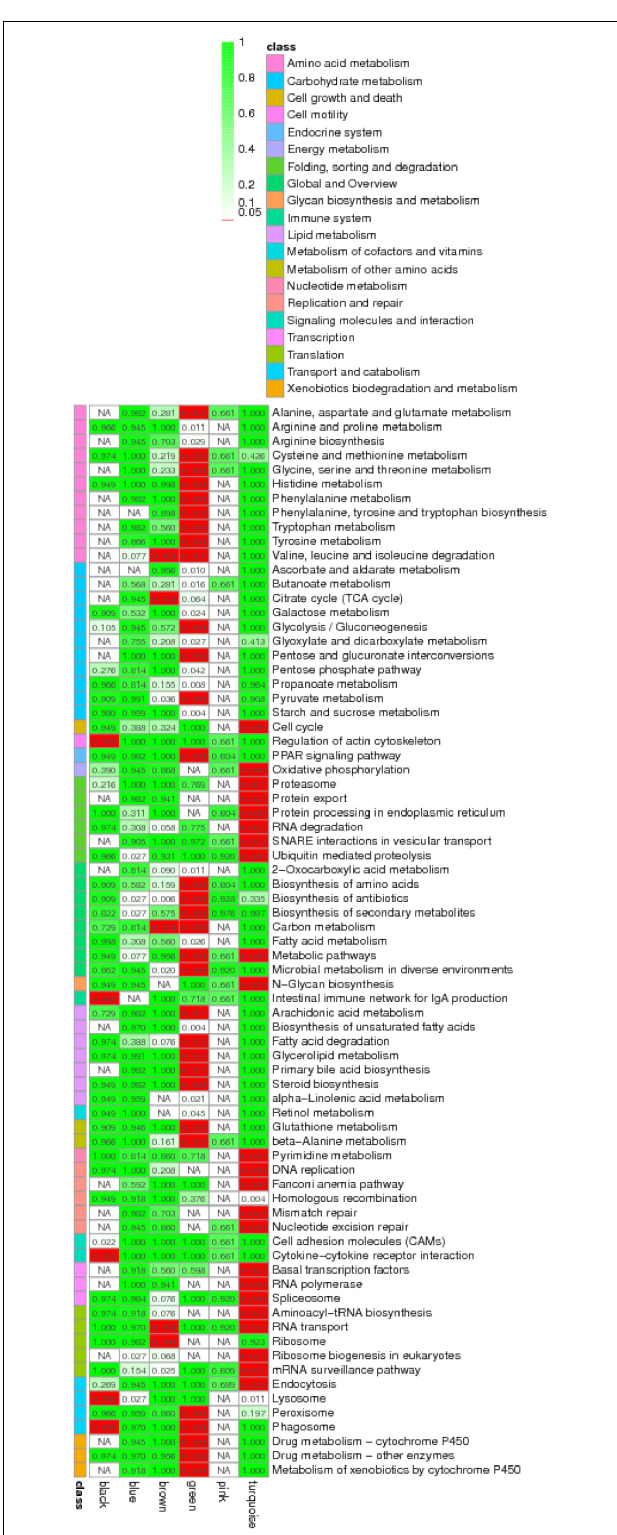
FIGURE 5 | Enriched KEGG pathway annotation for miRNA–mRNA pairs by the weighted gene co-expression network analysis (WGCNA analysis) using